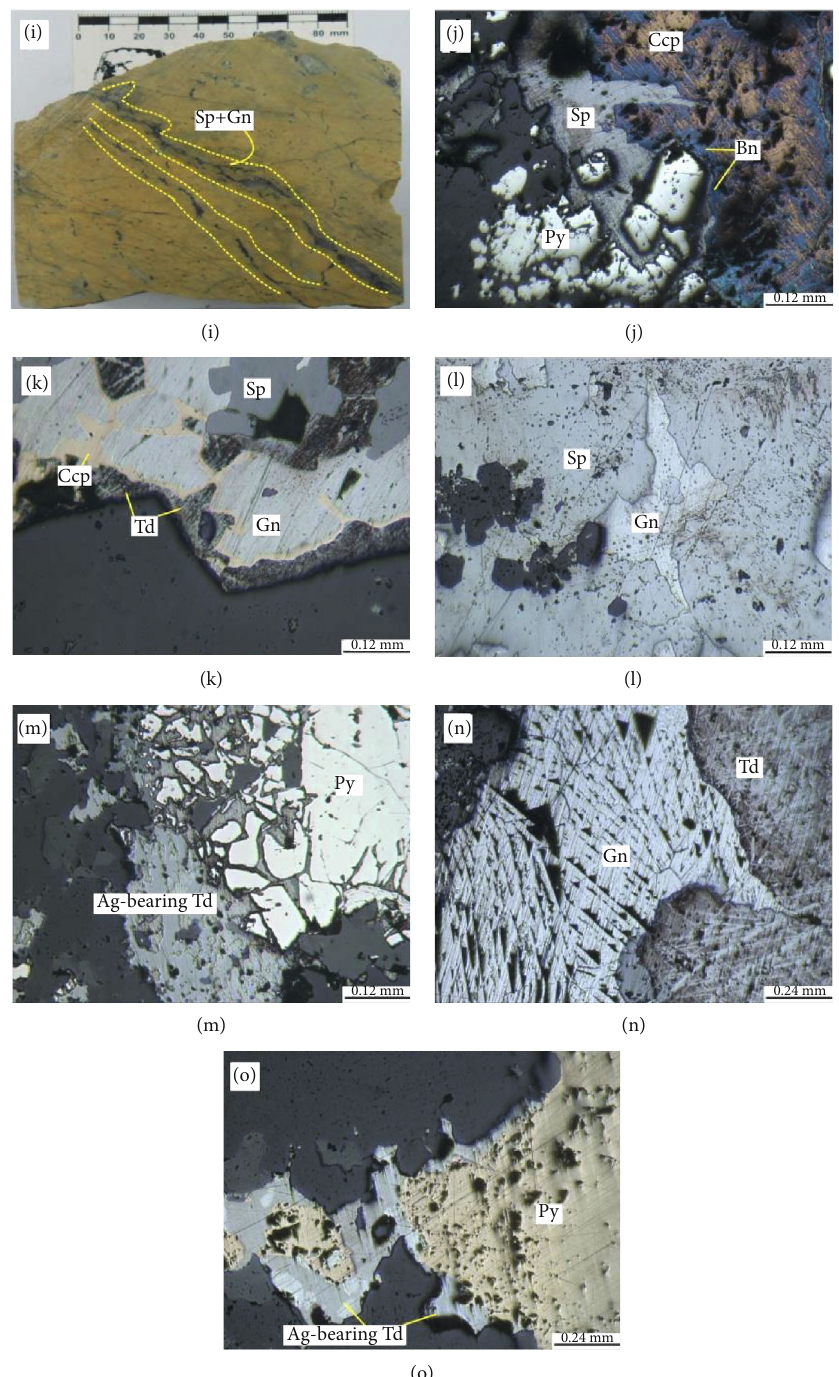
Figure 4: Photographs and photomicrographs of the Longmendian ore: (a) Ag – Pb – Zn ore veins; (b) banded Ag – Pb – Zn ore veins; (c) banded Cu – Ag – Pb – Zn ore veins; (d) early native Ag – Gn – Sp vein crosscut by late Py – Ccp – Gn – Sp vein; (e) banded/brecciated Ag – Pb – Zn ores and banded pyrargyrite ores; (f) brecciated pyrargyrite ore veins; (g) disseminated native silver in Ag – Pb – Zn veins; (h) veined and disseminated native silver in Ag – Pb – Zn veins; (i) veined Ag – Pb – Zn ores in tu ff ; (j) Sp (replacing Py) is replaced by Ccp; (k) Td replaced Gn; (l) Gn replaced Sp; (m) Ag-bearing Td replaced Py; (n) Gn replaced Td; (o) Ag-bearing Td replaced Py. Py: pyrite; Gn: galena; Sp: sphalerite; Ccp: chalcopyrite; Td: